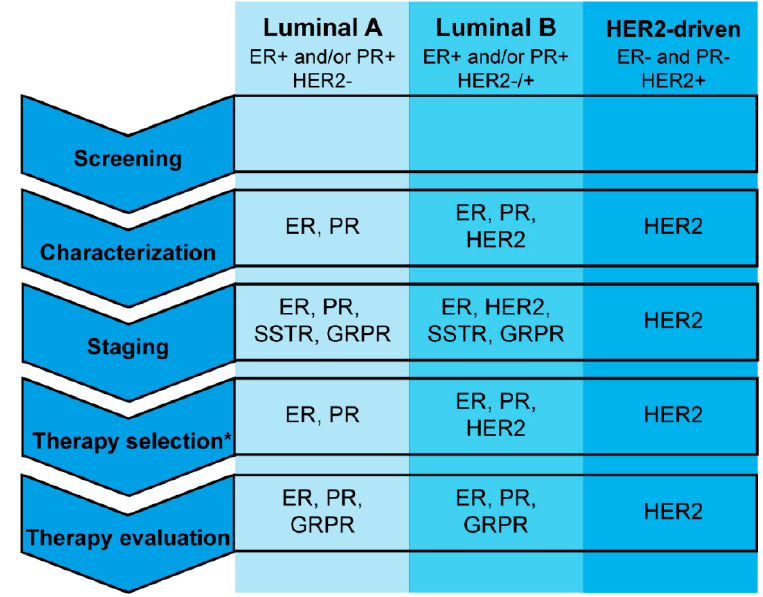
Figure 4. Overview of the (potential) clinical application of radiotracers targeting the estrogen receptor (ER), progesterone receptor (PR), human epidermal growth factor receptor 2 (HER2), somatostatin receptor (SSTR), and gastrin releasing peptide receptor (GRPR) for breast cancer imaging.* Therapy selection refers to currently clinically used hormonal and chemotherapies as discussed in this article.